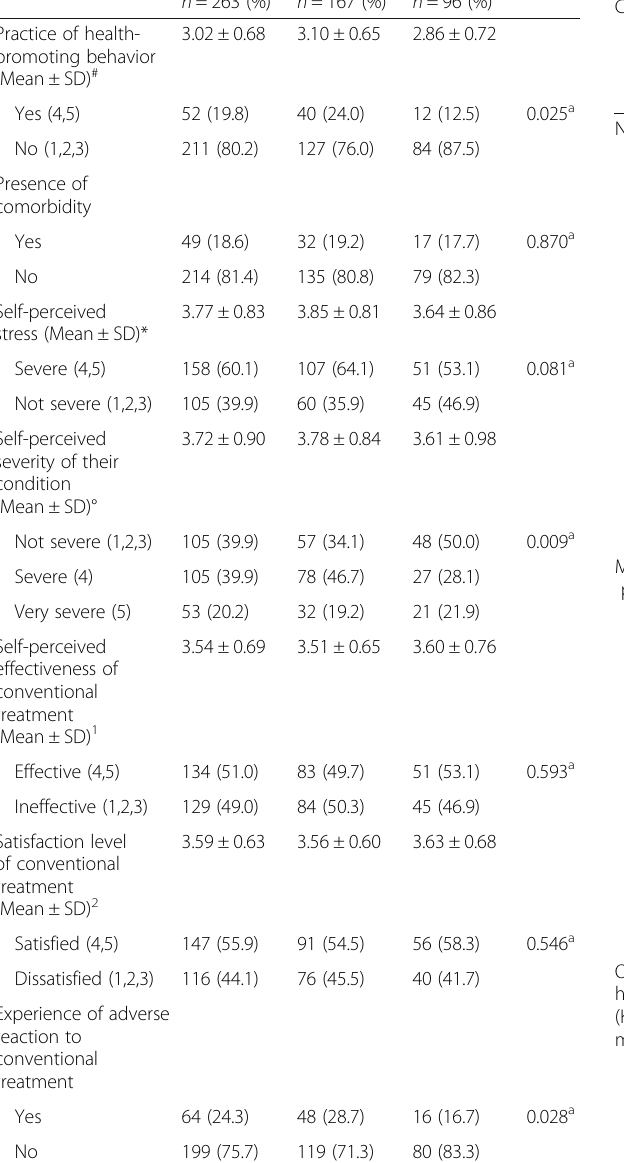
Table 4 CAM modalities used by infertile women based on their perceived level of disease